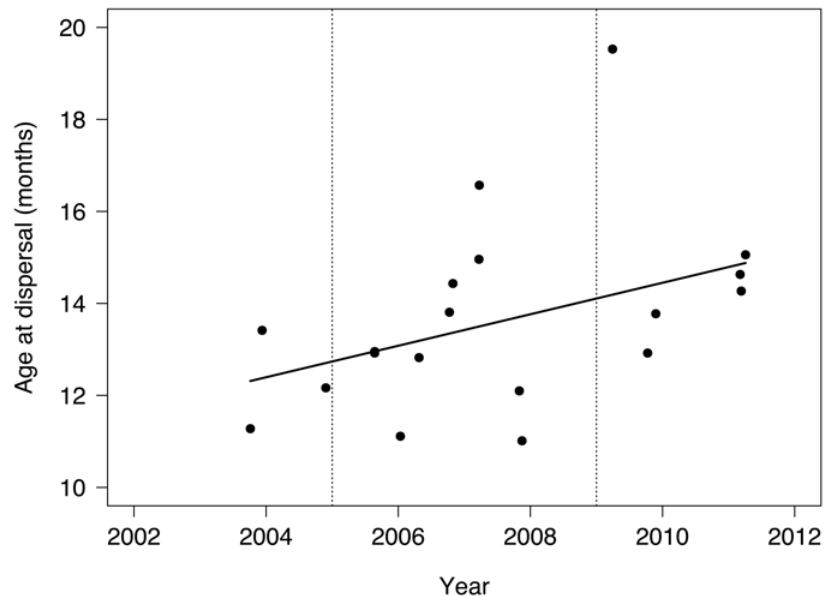
Fig 3. Age at commencement of dispersal in subadult leopards in Phinda Private Game Reserve, South Africa, 2002 – 2012. There was no significant difference in age at dispersal between sexes, and solid line indicates linear regression fitting all the data (R 2 = 0.118, F 1,18 = 3.534, p = 0.076). Fine-dotted lines show in 2005 the implementation of conservation protocol following leopard population decline, and in 2009 the time when the leopard population reached putative carrying capacity [21].